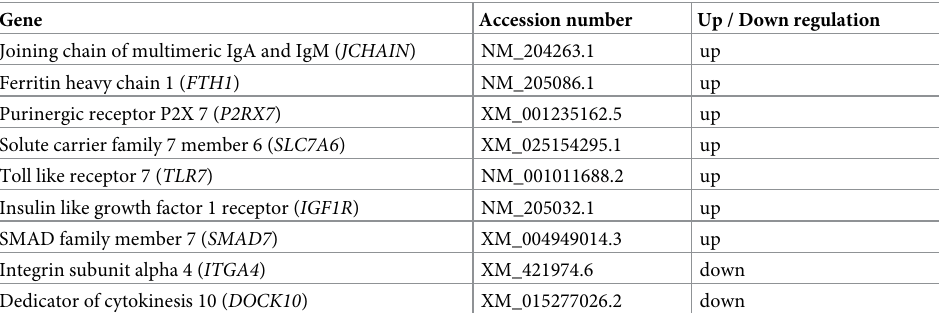
Table 3. Differentially expressed genes related to immunity screened by SSH. (Treated group vs Control group). Gene Accession number Up / Down regulation Joining chain of multimeric IgA and IgM ( JCHAIN ) NM_204263.1 up Ferritin heavy chain 1 ( FTH1